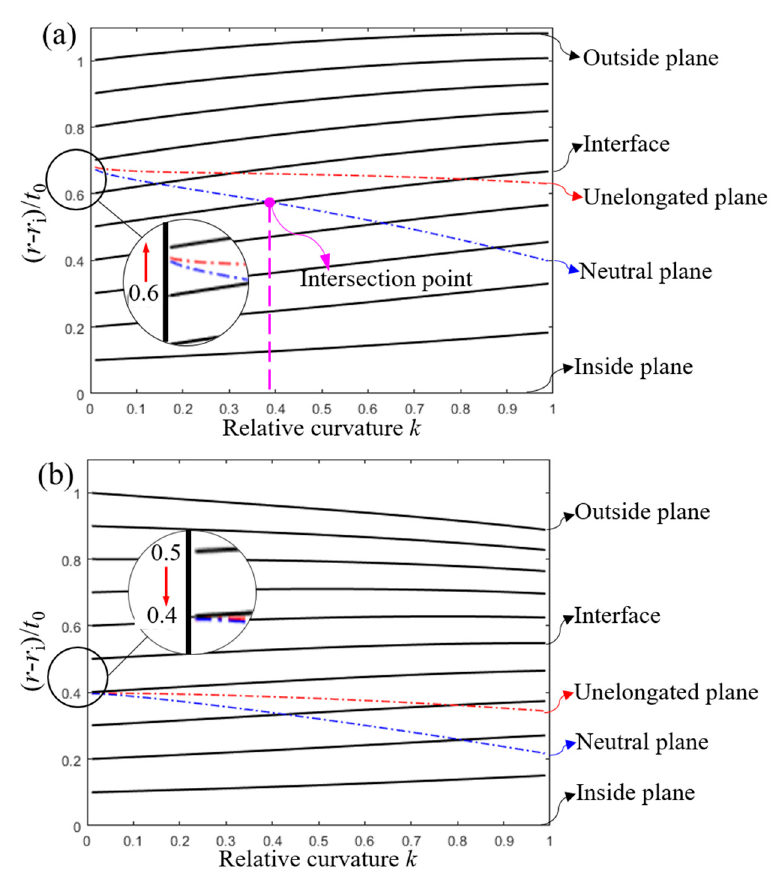
Figure 13. Position distributions of each segment with the increasing relative curvature at the hot working temperature of 950 °C: ( a ) with the outside 2205 steel layer, and ( b ) with the inside 2205 steel layer.